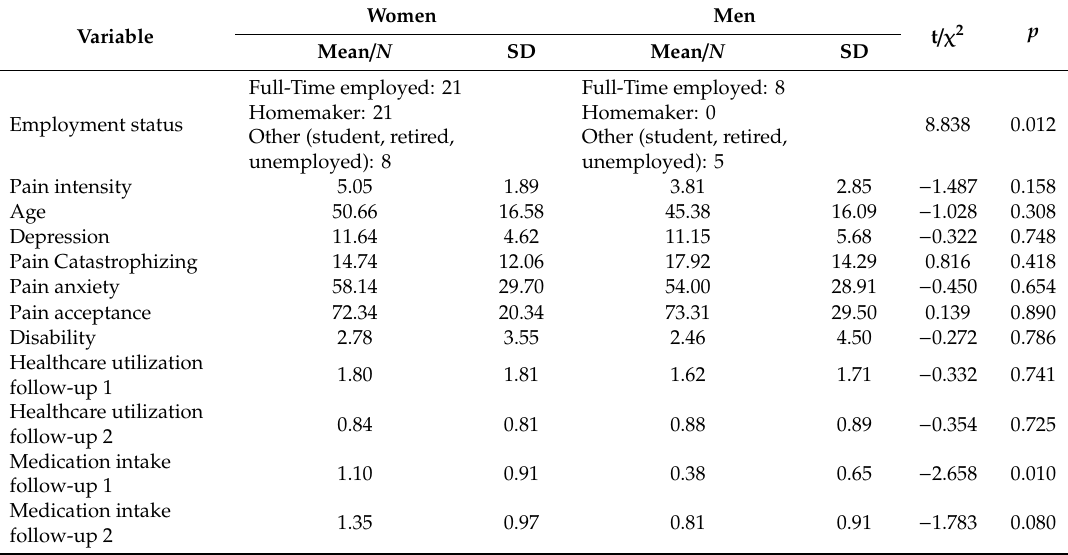
Table 2. Comparison of women and men on the predictor and outcome variables. T-tests and